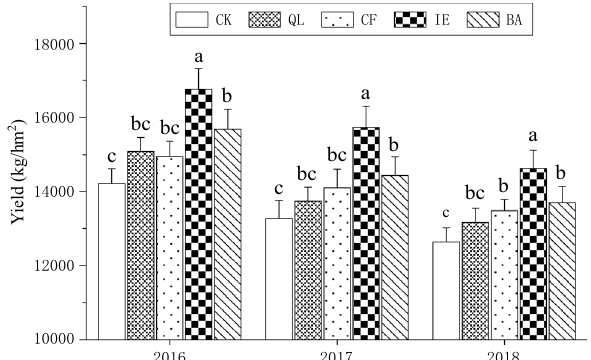
Figure 2. Effects of different treatments on the yield of continuous cropping lily. Bars indicate standard error (n = 3). Different letters above columns within the same species indicate significance at p < 0.05 according to